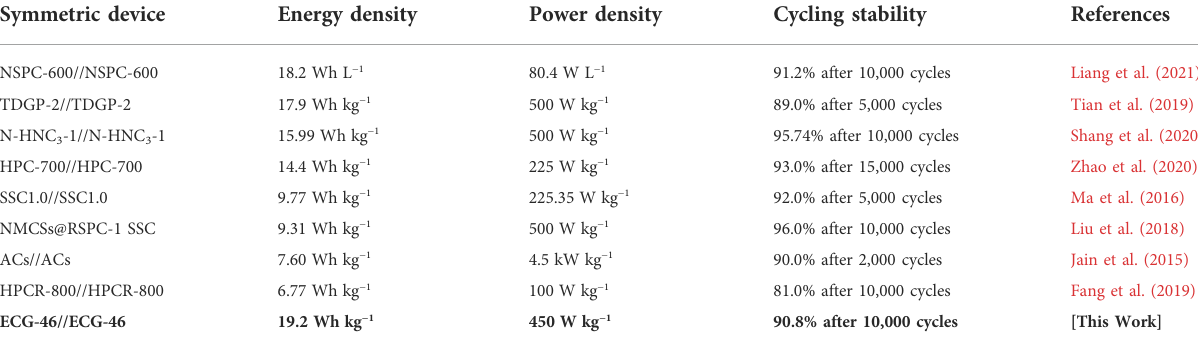
TABLE 2 Comparative electrochemical performance of ECG-46//ECG-46 symmetric device with previously reported